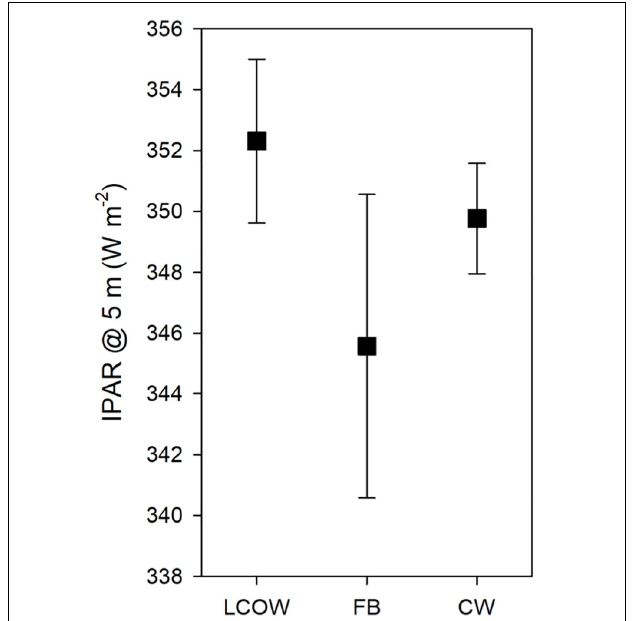
FIGURE 5 | Mean surface light intensity (IPAR) at 5 m water depth for each of the three oceanographic feature classes surveyed during DP01–DP04. LCOW, Loop Current-origin Water; FB, frontal boundary; and CW, Gulf Common Water. Error bars represent standard error of the mean.